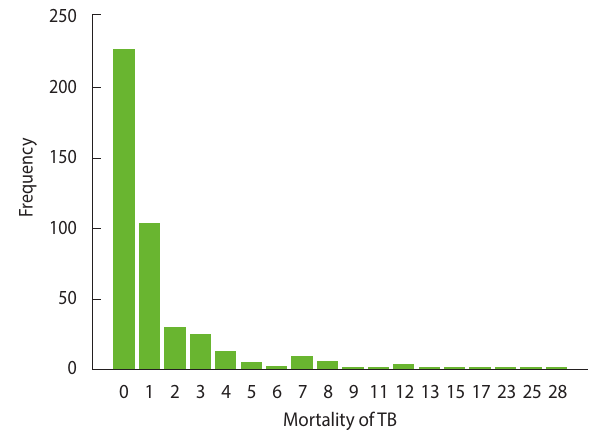
Figure 1. The number of deaths from tuberculosis (TB) in Iran.